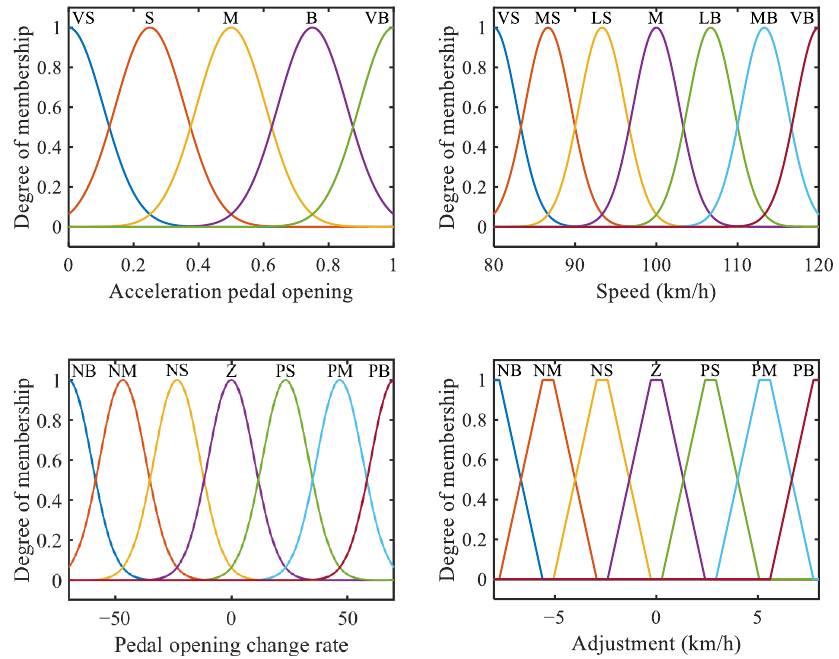
Figure 10. Membership functions of the input and output variables in fuzzy rules of dynamic shifting strategy.